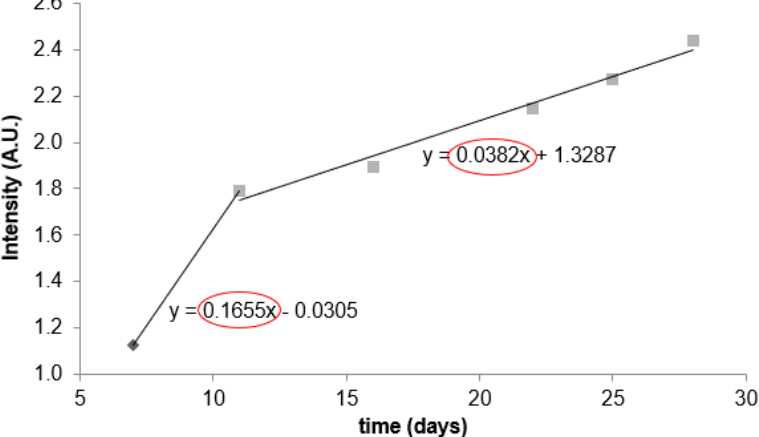
Figure 5. Intensity curve representing the ratio of the average nodule and Matrigel intensity over 28 days gives a broader picture of GNP behavior in a 3D model. GNP uptake by nodules was most rapid up to day 11 of nodule growth (during the first 4 days after the addition of labeled nanoparticles). After this period, uptake slowed down due to lower GNP concentration in Matrigel, confirmed by a slope 2 (11 – 28 days) value (0.0382), which is more than four times less than slope 1 (7 – 11 days) value (0.1655).